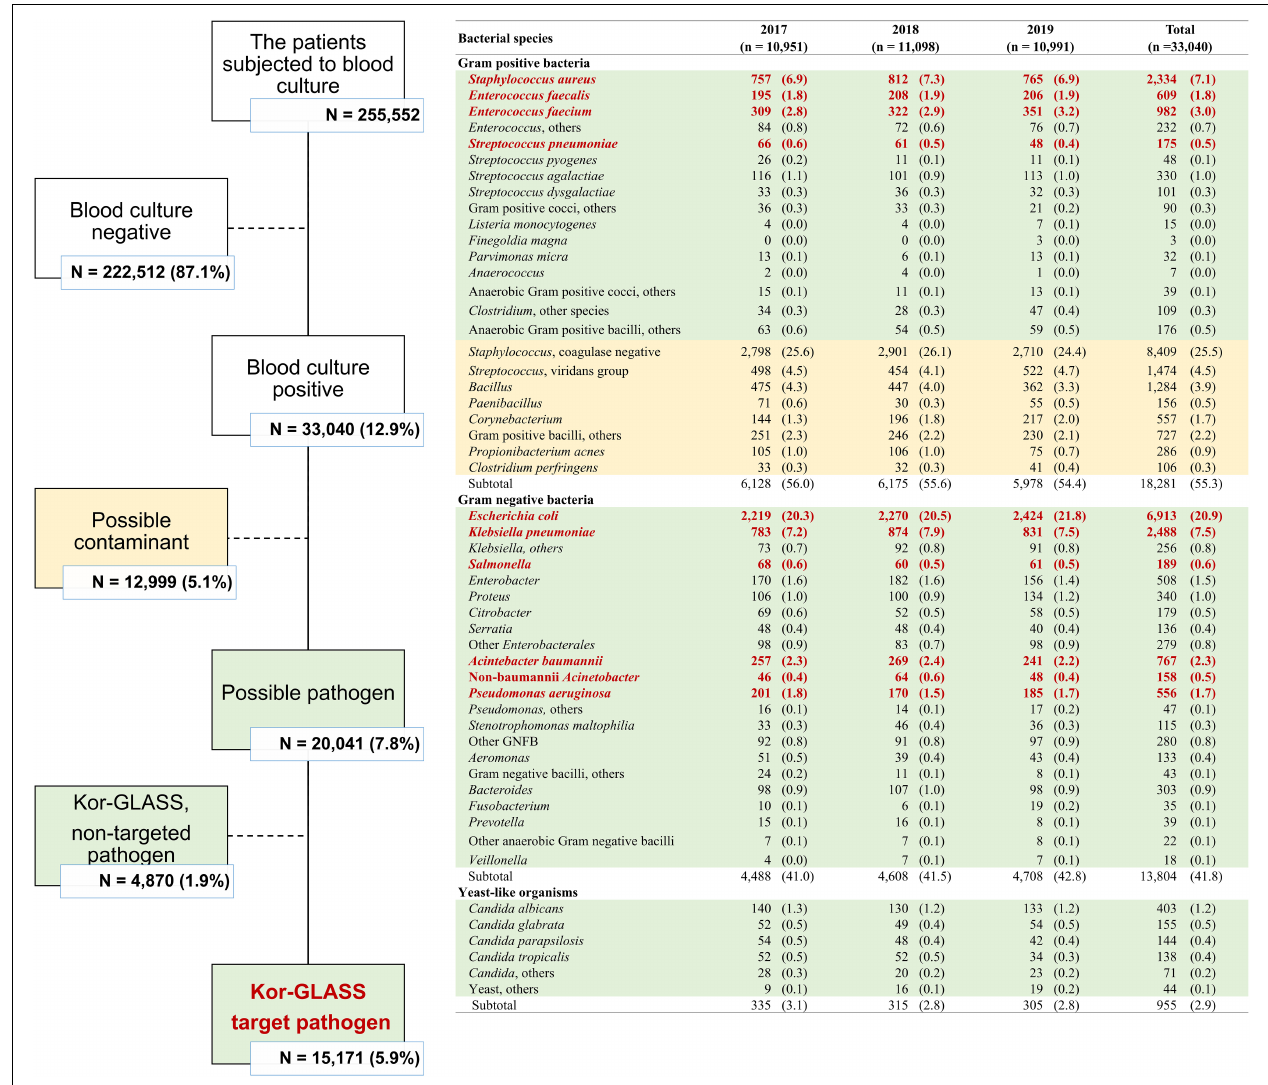
FIGURE 1 | Bloodstream infection cases stratified according to the pathogen during the study period.